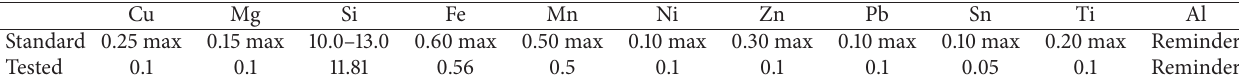
Table 1: Chemical composition of A413 aluminium alloy in wt.